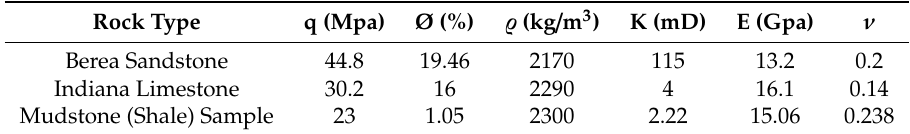
( b ) Figure 11. Evolution of mean shear force and mean surface roughness versus DOC: ( a ) mean shear force; ( b ) mean groove roughness. Figure 12 indicates an inverse relationship between the mean roughness of the scratched path and the cutting force. The equation illustrated in the graph can be used to calculate the average asperity of the rock surface for each DOC. In the literature, the averaged tangential force has been published for different DOCs in Berea sandstone. The combination of the equation shown in Figure 12 and the mean shear load from published articles can be used to calculate the mean surface roughness value for various DOCs. After finding the average asperity of the groove surface, the scratched rock surface can be reproduced by employing the Weierstrass-Mandelbrot model for the given DOC.